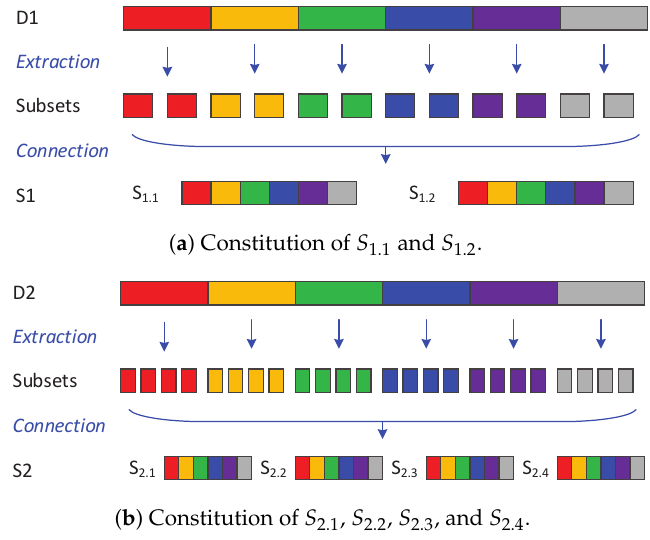
Figure 4. Illustration of data